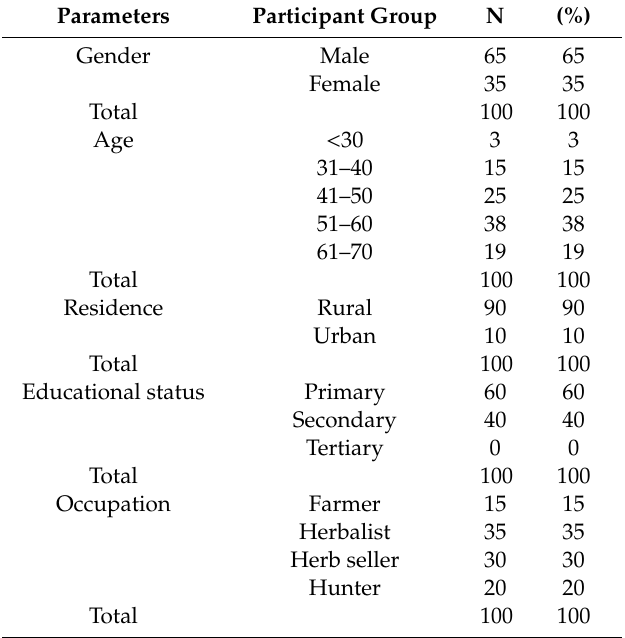
Table 1. Demographic characteristics of the participants ( n = 100) in the study area.